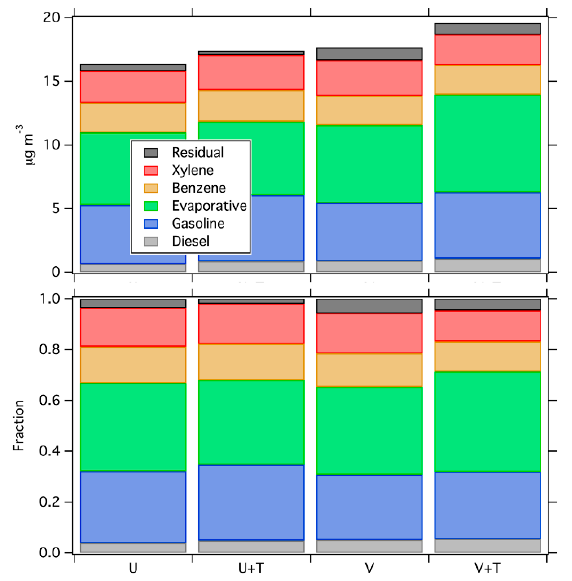
Figure 11. The concentrations and fractions of each factor in each type of site. The source mix is similar across the various land uses.